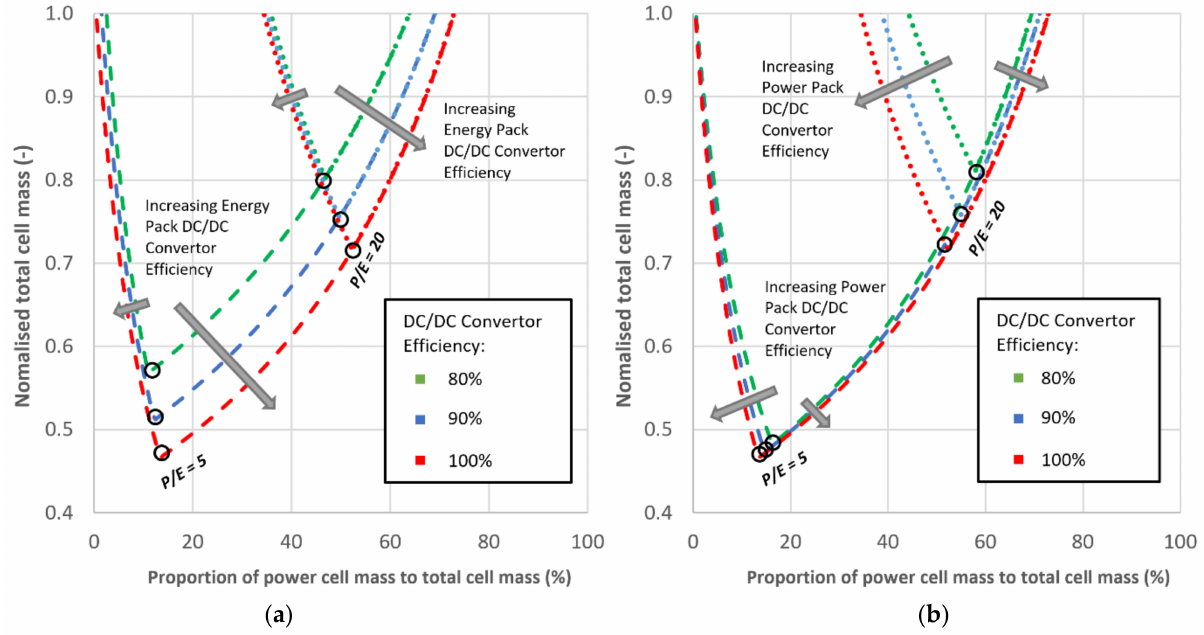
Figure 5. Overall total cell mass for varying power cell to total cell mass for a PE 5 and PE 20 applications by considering the impact of ( a ) a DC/DC converter on the energy pack varying from 100 to 80% efficiency and ( b ) a DC/DC converter on the power pack varying from 100 to 80%